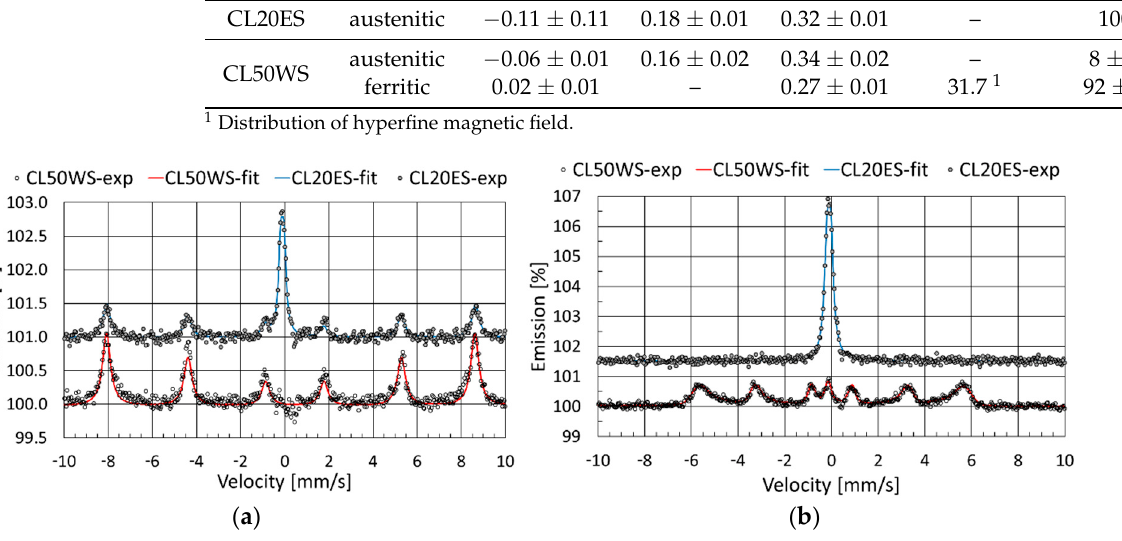
Figure 9. CEMS of ( a ) Sample2 (CL20ES) and Sample5 (CL50WS); ( b ) Sample3 (CL20ES) and Sample 6 (CL50WS).